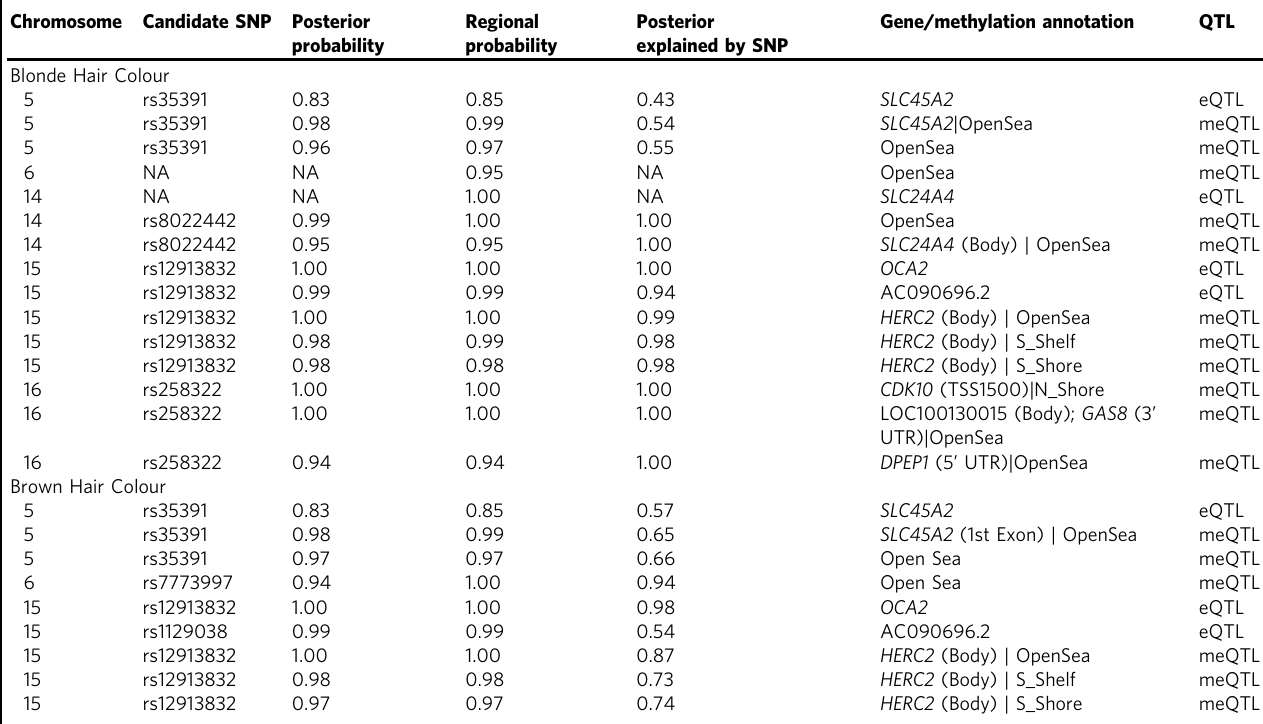
Table 1 Colocalization results of expression and methylation cis -QTLs from cultured melanocytes (eQTL and meQTL, respectively) with GWAS SNPs on each hair colour category.